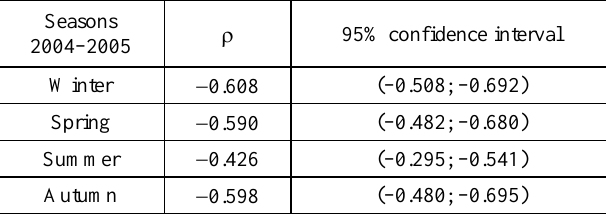
Table 2. Correlation coefficients ( ρ ) with confidence interval between HCRF and atmospheric pressure in